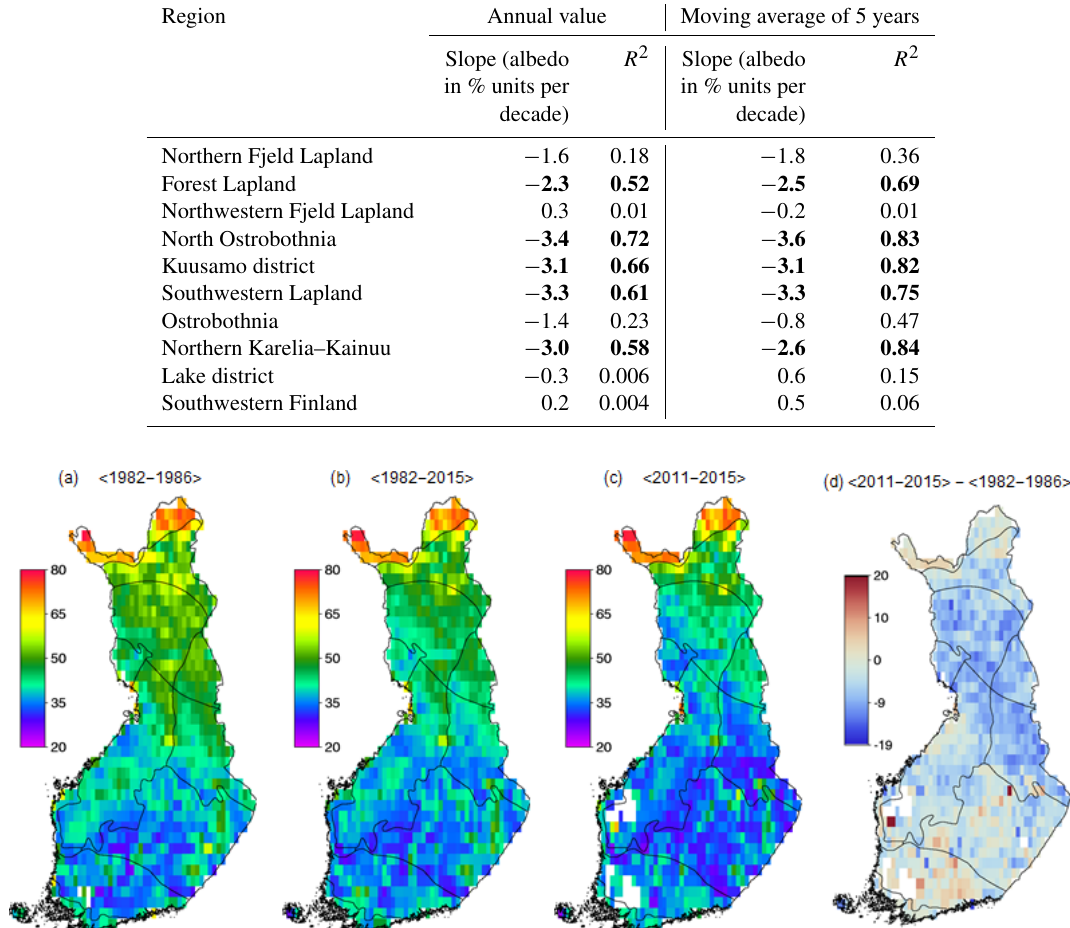
Figure 9. The surface albedo (%) at the time of the melt onset in Finland. The average value during 1982–1986 (a) , during 1982–2015 (b) and during 2011–2015 (c) . The difference between the last and first 5 years’ average value is shown as well (d) . The white pixels on land represent cases when the melting has already started before the albedo could be retrieved, i.e. when the sun zenith angle was larger than 70 ◦